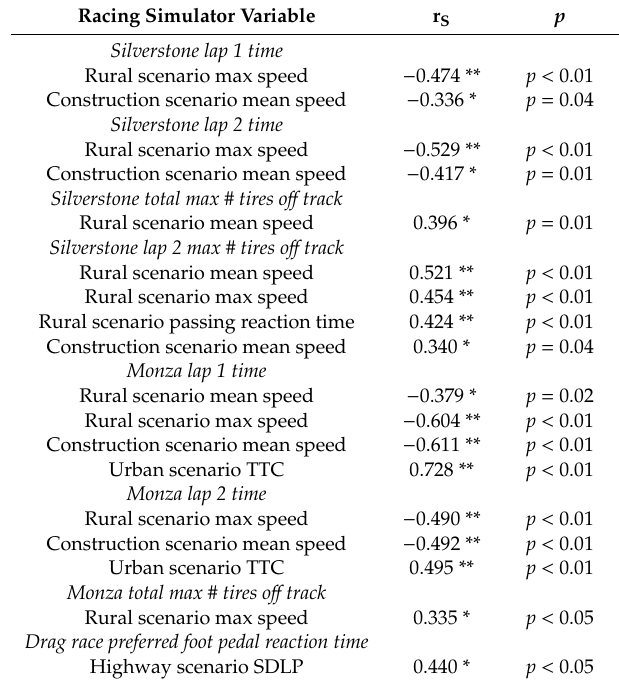
Table 8. Significant Spearman correlations of racing simulator to research simulator